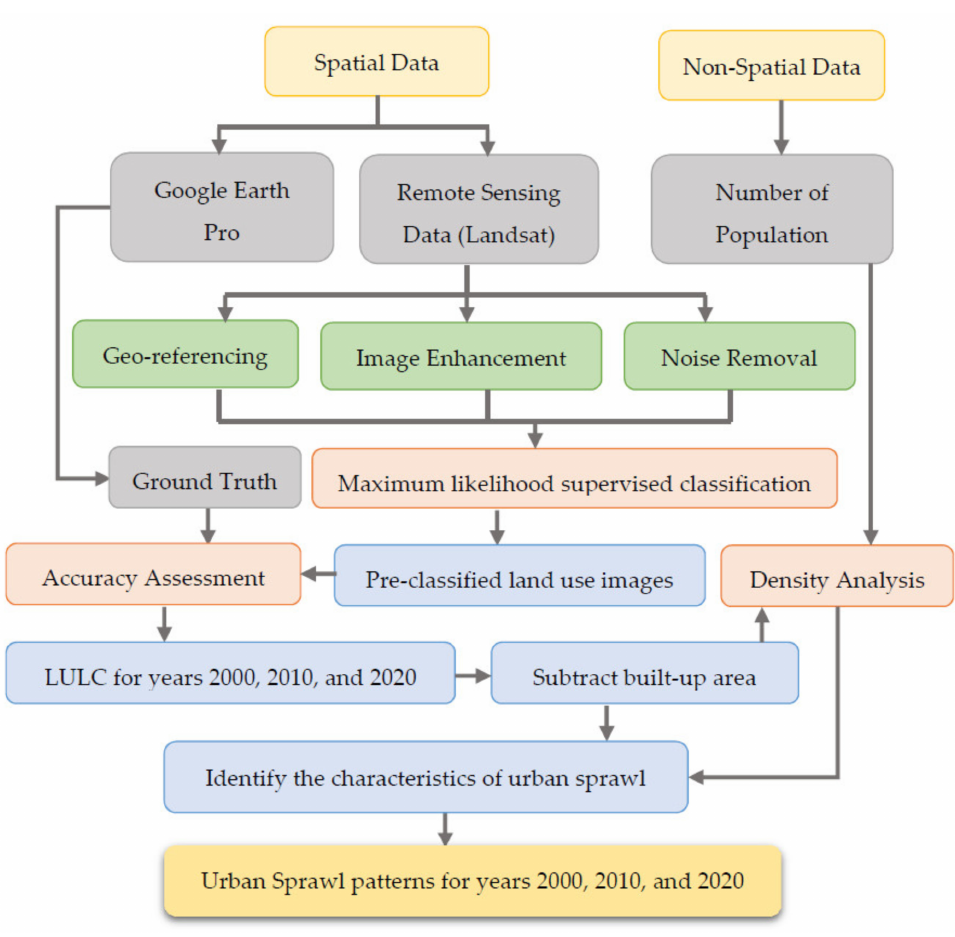
Figure 3. The methodological framework for identifying urban sprawl